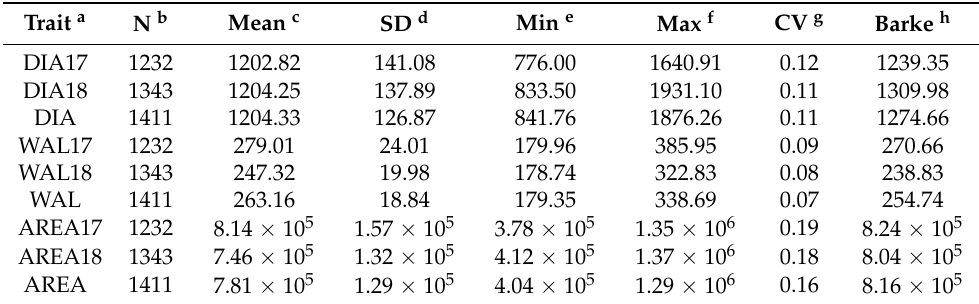
Table 1. Descriptive statistics for each year and best linear unbiased estimates (BLUEs) across environments (DIA/WAL [ µ m], AREA [ µ m 2